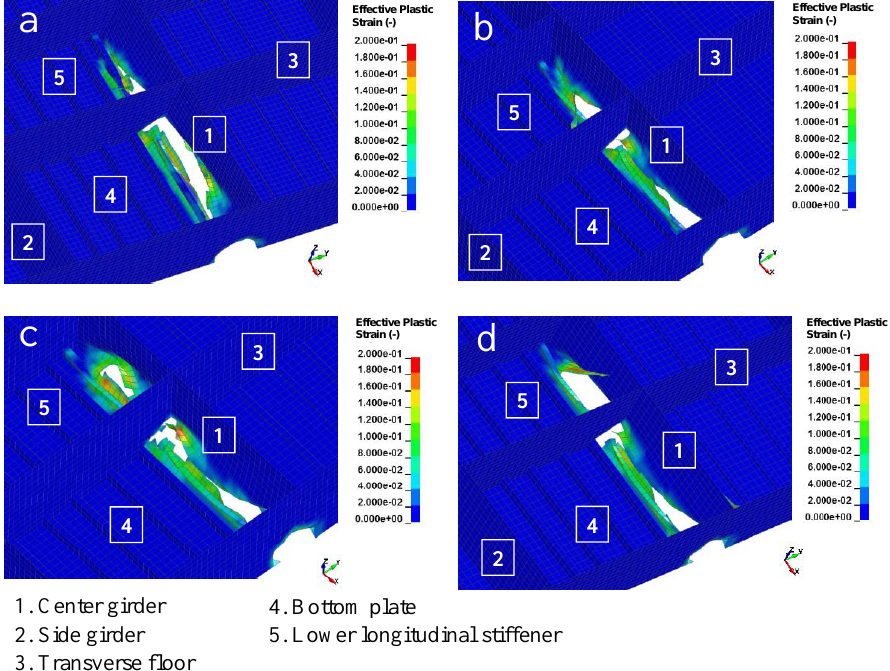
Figure 14. Strain contours (effective plastic strain) after the steel-plated structure was grounded on different meshes: (a) 120 mm, (b) 132 mm, (c) 144 mm, and (d) 156 mm.